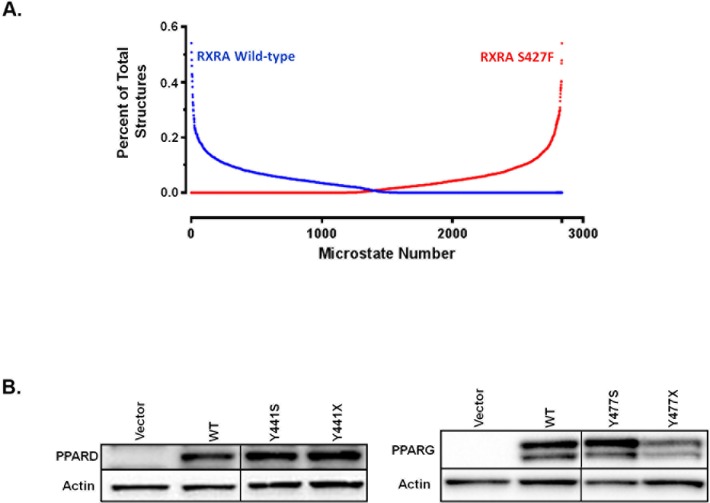
(A) Distribution of micro-state clusters occupied in RXRAwt and RXRAS427F simulations. (B) Western blot confirming expression of PPARD and PPARG with terminal tyrosine mutation or deletion in transfected UM-UC-3 cells. Irrelevant intervening lanes were removed where indicated with vertical bar without further image manipulation.